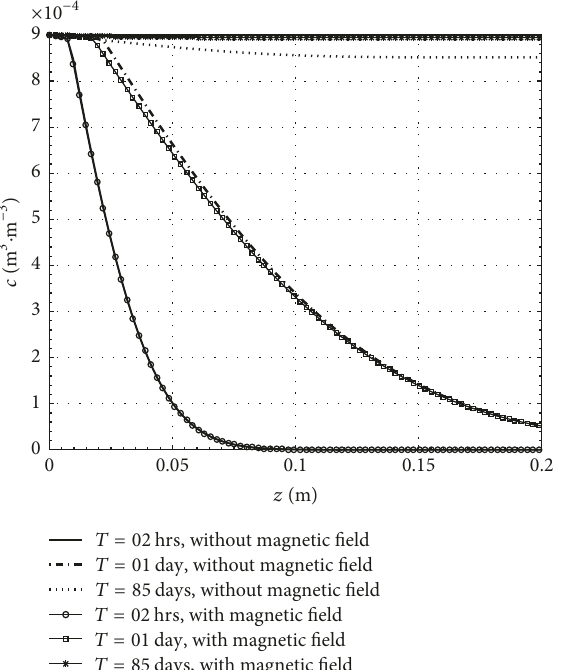
Figure 11: Nanoparticles concentration against core length with and without magnetic field effect for various values of imbibition time: magnet is placed on the left side of the core.